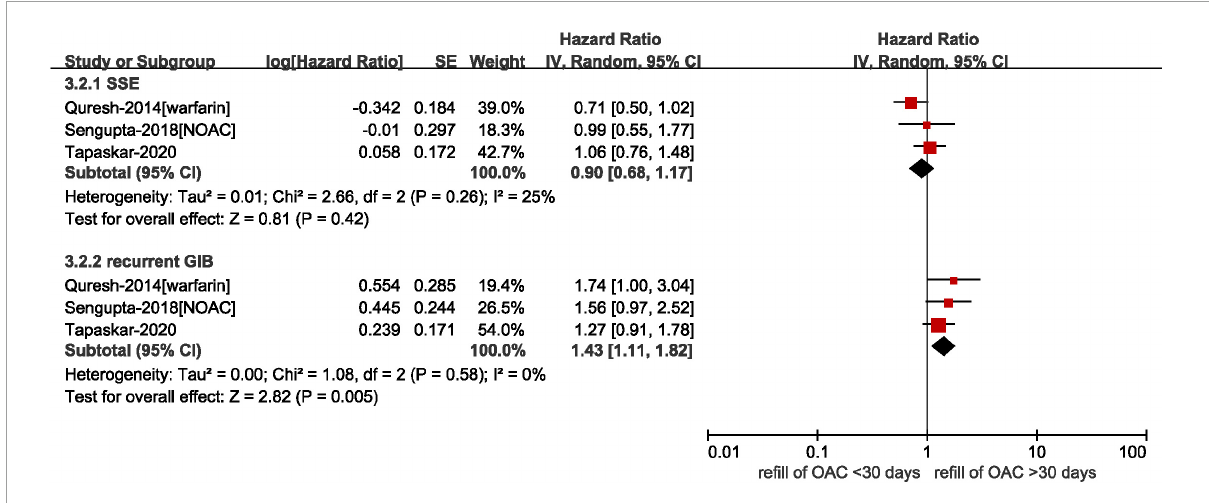
FIGURE4 Comparing the effect of different time to resume anticoagulation in AF patients with prior GIB. AF, atrial fibrillation; GIB, gastrointestinal bleeding; OAC, oral anticoagulants; NOAC, non-vitamin K antagonist oral anticoagulants; CI, confidence interval; IV, inverse of the variance; SE, standard error; SSE, stroke and systemic